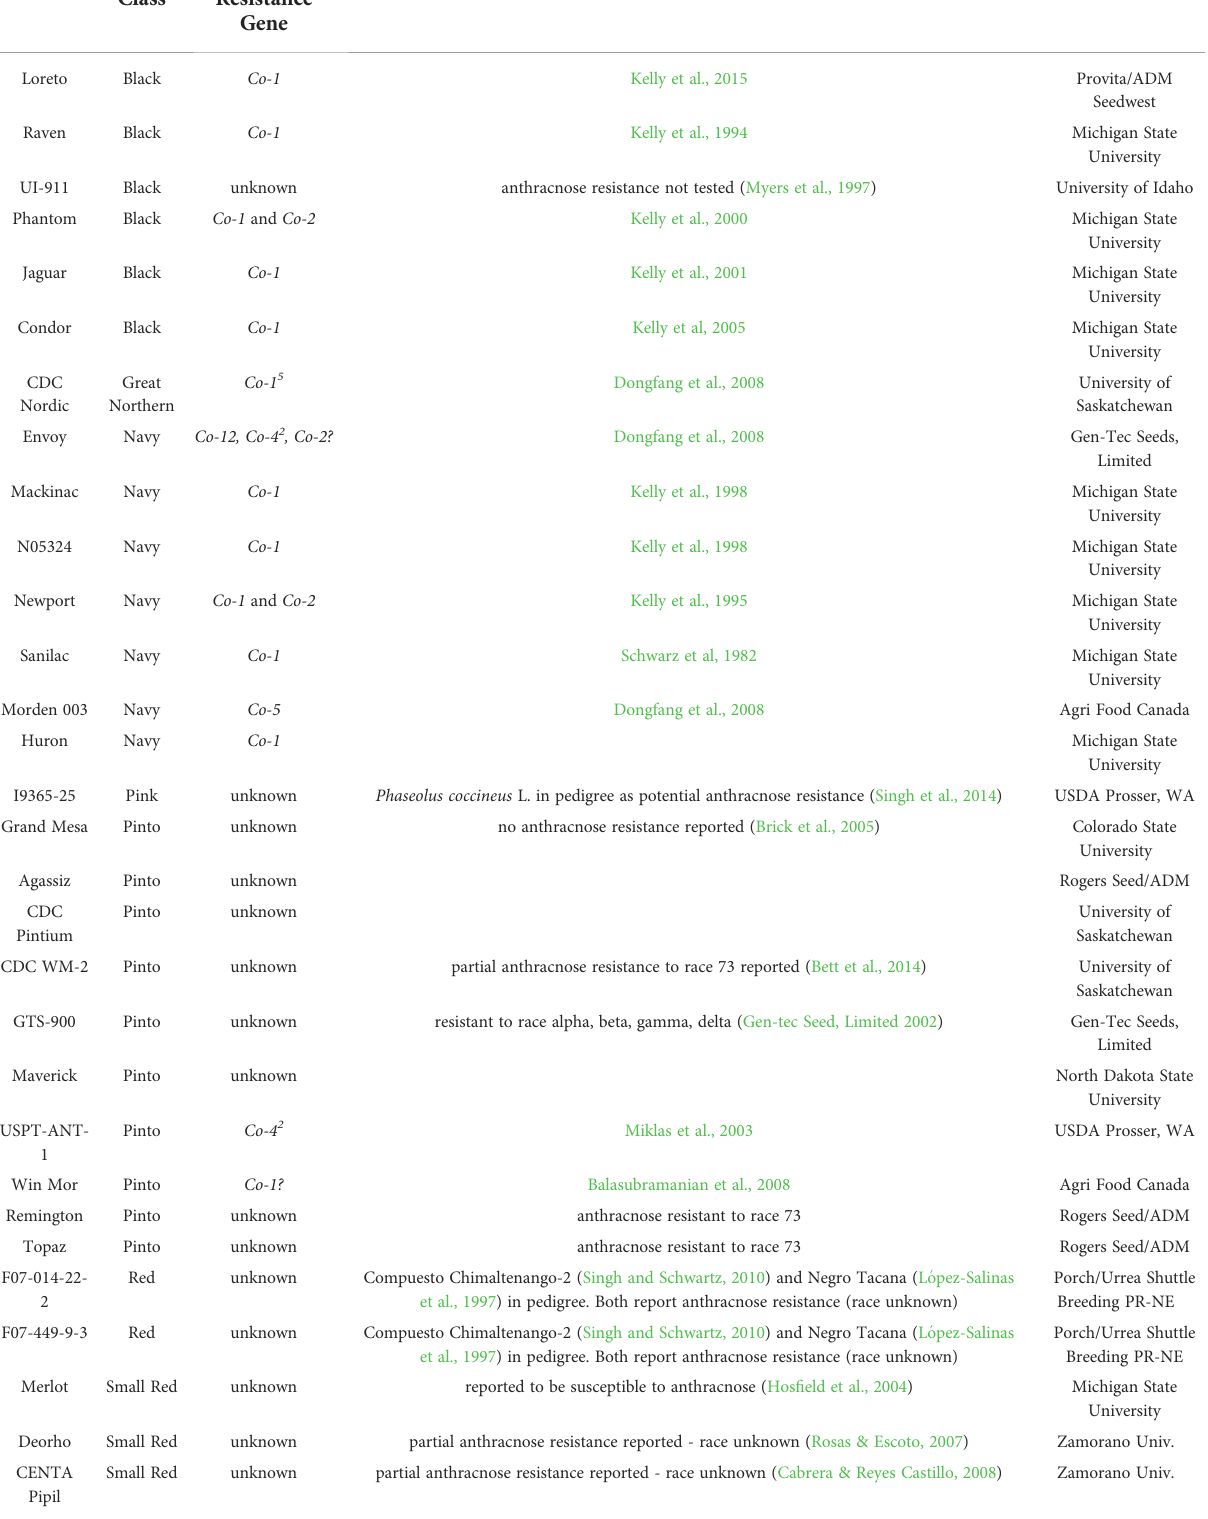
TABLE 1 Characteristics and history of MDP genotypes exhibiting resistance under the trifoliate screening method (condensed 1-3 rating scale) including their previously reported anthracnose resistance genes to any race of anthracnose. Genotype